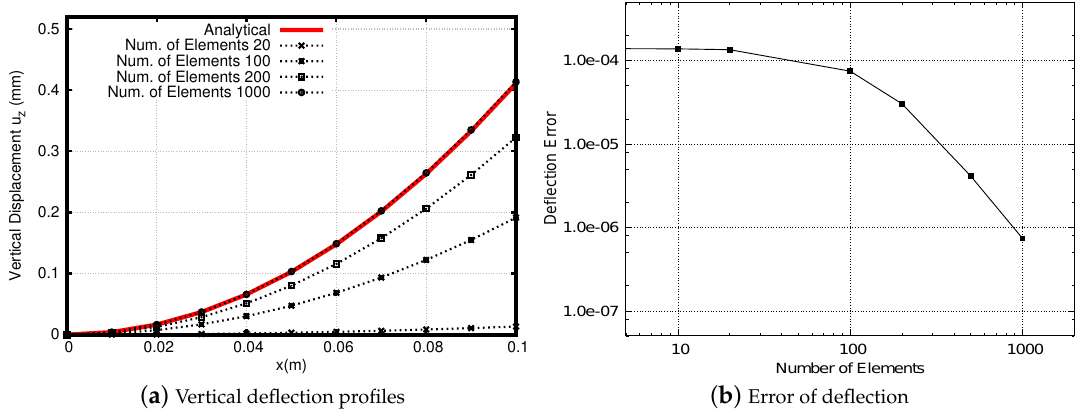
Figure 5. Comparison of FEM results with analytical data for the bimorph beam case: ( a ) deflection profile along the x -axis and ( b ) deflection error along the length of the bimorph beam with the increasing number of elements in the simulation.